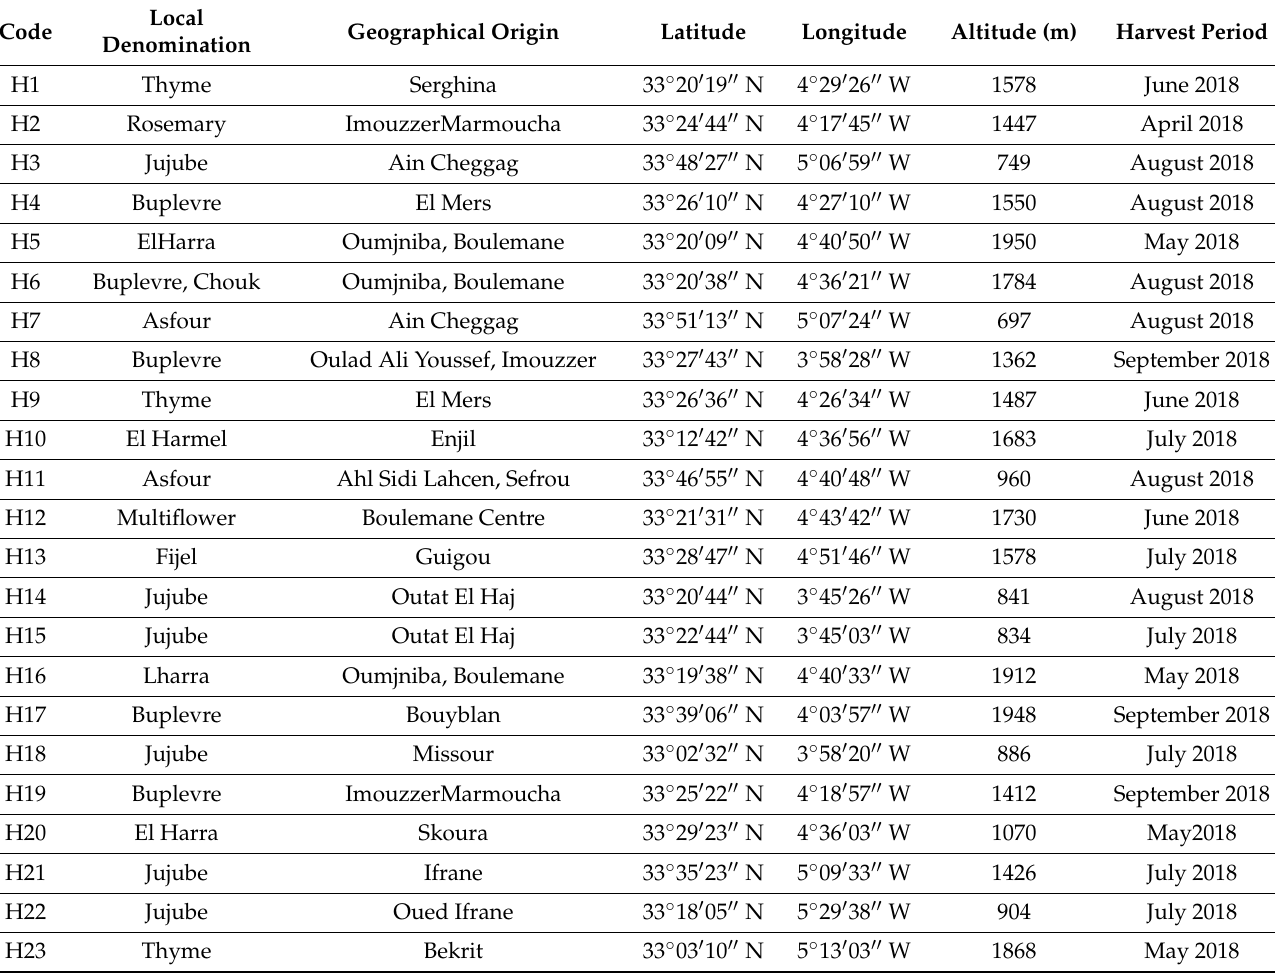
Table 1. Honey samples, origins, and harvesting